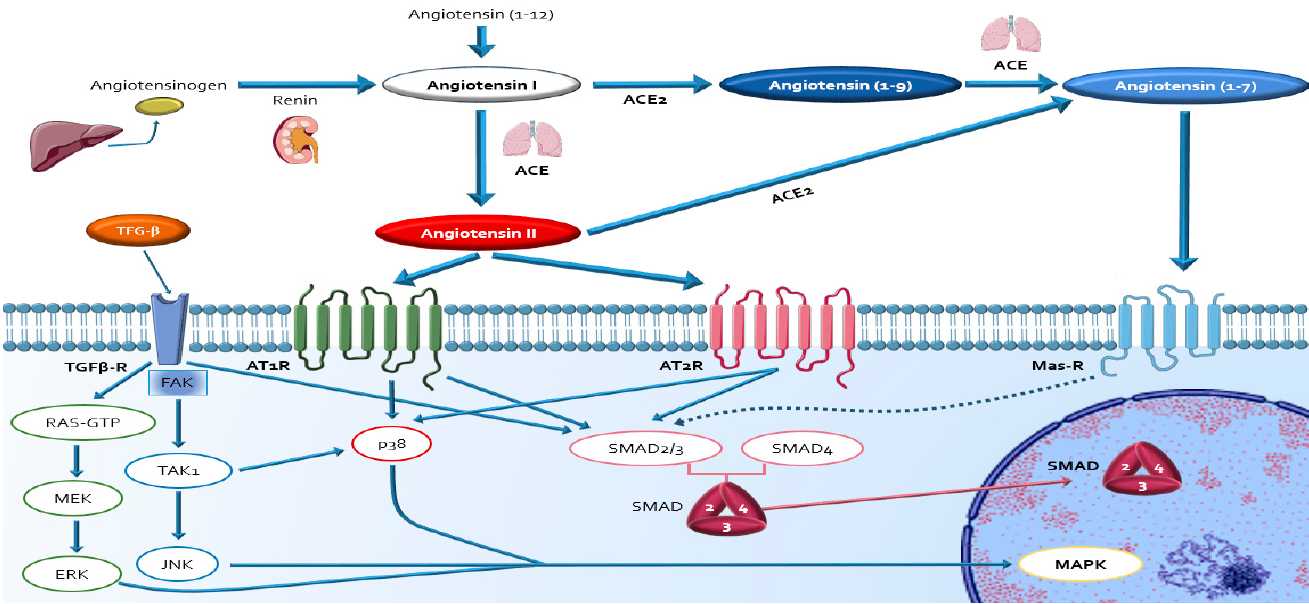
Figure 3. Integrated schematic representation of the local RAAS (classical (ACE/Angiotensin 2/ATR) and counterregulatory non-classical (ACE2/Angiotensin1-7/Mas-r), with its main pro-fibrotic intracellular mechanisms, and its relevant interactions with the profibrotic TGF- β pathway. TGF- β transduce its signal from Table 126. The activation of alternative SMAD-independent signalling cascades (non-canonical pathways) by Table 38. MAPKs, is also required for myofibroblasts pro-fibrotic actions enhancing transcription of pro-fibrotic signals, including TGF- β itself, as part of the positive feedback in fibrosis [127].Abbreviations: ACE: angiotensin-converting-enzyme; ALK5: activin receptor-like kinase-1; AT1R: angiotensin II receptor type 1; AT2R: angiotensin II receptor type 2; ERK: extracellular signal-regulated kinase; FAK: focal adhesion kinase; JNK: Jun N-Terminal Kinase; MAPK: mitogen-activated protein kinase; MasR: Mas receptor; MEK: MAPK/ERK kinase SMAD: mothers against decapentaplegic homolog; TAK1: tumour growth factor β -activating kinase-1; TGF- β R: transforming growth factor- β